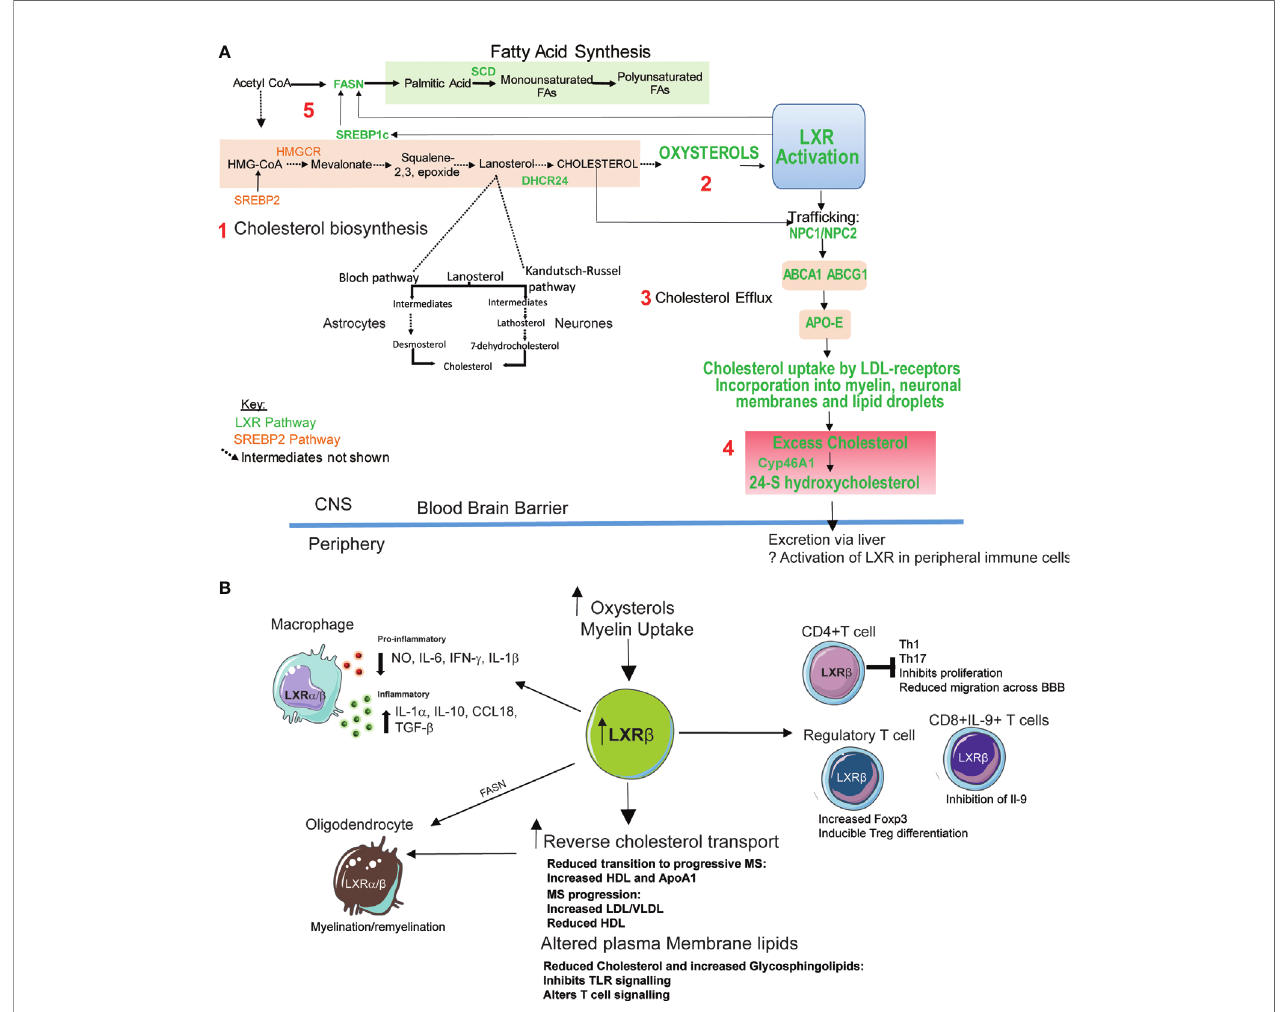
FIGURE 1 | Potential therapeutic roles of LXR activation in MS. (A) Intracellular cholesterol levels in the brain are tightly regulated by two transcription factors (61): 1. Liver-X-receptor (LXR) and sterol response element binding-protein 2 (SREBP-2). SREBP2 upregulates genes involved in cholesterol biosynthesis. Cholesterol in the brain is produced de novo mainly by glial cells such as astrocytes using the Bloch pathway. Neurons which have a high cholesterol requirement produce less cholesterol via the Kandutsch-Russell pathway. 2. LXR is activated by by-products of cholesterol synthesis (oxysterols). 3. LXR activation promotes cholesterol export via intracellular cholesterol transporter Niemann Pick Type C1 and 2 (NPC1/NPC2), and ATP binding cassette (ABC) A1 and ABCG1 which ef fl ux cholesterol from the plasma membrane to high density lipoprotein (HDL)-like lipoproteins including apolipoprotein-E (Apo-E). 4. Cholesterol is taken up by cells via lipoprotein receptors. Excess cellular cholesterol (potentially generated by neurodegeneration processes) is stored in lipid droplets or converted into oxysterols. 24-S hydroxycholesterol is the most abundant oxysterol in the brain and its production is catalyzed by the enzyme Cyp46A1 (cholesterol 24S-hydroxylase). 24-S hydroxycholesterol is able to cross the blood brain barrier to the periphery where it is degraded in the liver. 5. LXR also promotes fatty acid synthesis through its target genes SREBP1c, fatty acid synthase (FASN) and stearoyl-CoA desaturase (SCD). Plasma membrane levels of cholesterol and fatty acids can in fl uence lipid rafts-membrane microdomains important for immune synapse formation and immune cell activation and function. Fatty acid (glycosphingolipid) abundance and composition can also in fl uence plasma membrane fl uidity (64). (B) LXR b expression is elevated in peripheral blood mononuclear cells from MS patients potentially due to increased levels of oxysterols including 24S-hydroxycholesterol. Increased LXR activation can also be triggered by myelin uptake by glial cells in the central nervous system (CNS). LXR activation induces reverse cholesterol transport ( A , 4). Patients with MS have altered lipoprotein pro fi les which may re fl ect defects in the ef fi cacy of this process. MS progression is associated with reduced levels of high density lipoproteins (HDL)- responsible for effective cholesterol ef fl ux. LXR activation also induces fatty acid and glycosphingolipid biosynthesis ( A , 5). Changes in cellular cholesterol and glycosphingolipids can alter immune cell function by altering cell signaling and downstream functions including proliferation and cytokine production. In T-cells LXR activation reduces T-cell in fi ltration into the CNS (65) and inhibits naïve CD4+ T-cell differentiation towards an in fl ammatory Th17 phenotype (66) and suppressed IL-9 producing CD8+ T cells during anti-tumor responses (67). LXR activation is crucial for Treg function (68). LXR activation stimulates oligodendrocyte myelin production and remyelination processes (69). Mechanisms include stimulation of reverse cholesterol transport and fatty acid synthesis. LXR activation leads to the repression of in fl ammatory responses through the downregulation of pro-in fl ammatory genes including inducible nitric oxide synthase (NO), interleukin (IL)-1 b , IL-6 and tumor necrosis factor- a . Myelin uptake by macrophages activates LXR and suppresses the production these pro-in fl ammatory mediators These myelin-laden macrophages, express high levels of anti- in fl ammatory IL-1-receptor- a , IL-10, CC-chemokine ligand-18 and transforming growth factor- b